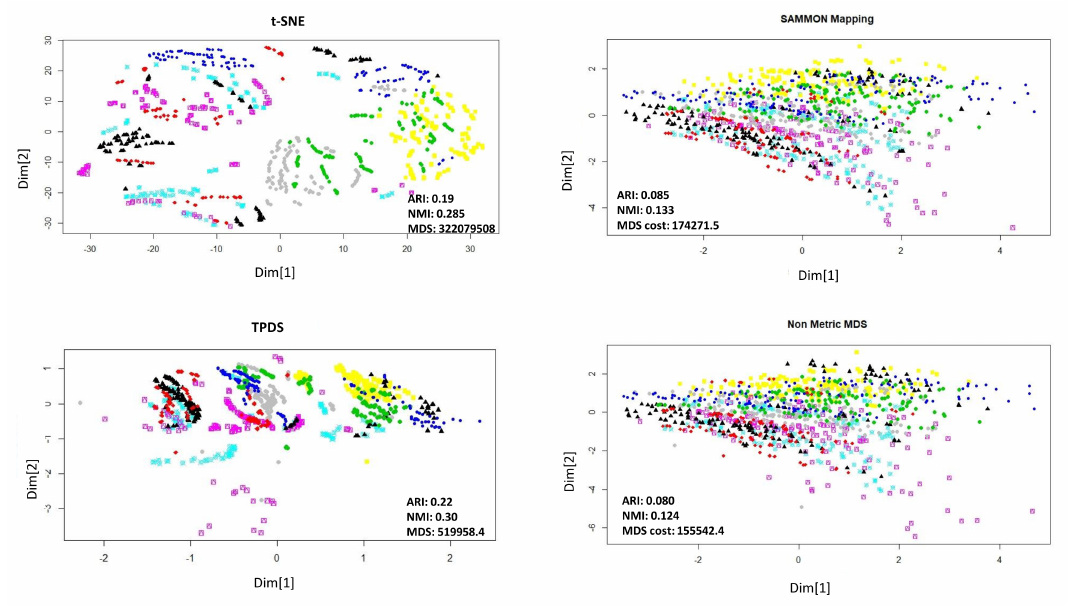
Figure 2. Dimension reduction of mouse protein data set. Visualization of reduction to two dimensions. The distance stress-based cost is represented as MDS-cost. The neighborhood proximity of data-points belonging to same class is better in TPDS output than t-SNE.